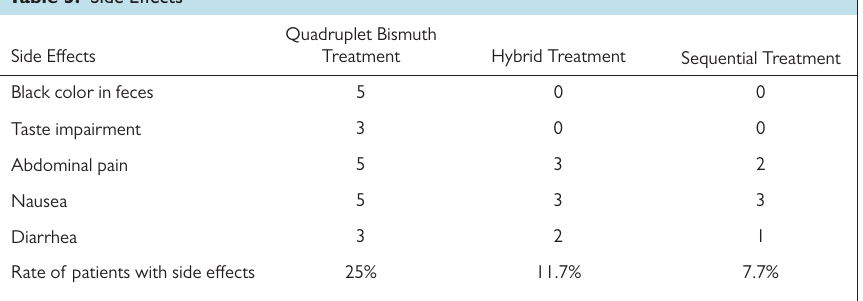
Table 3. Side Effects Side Effects